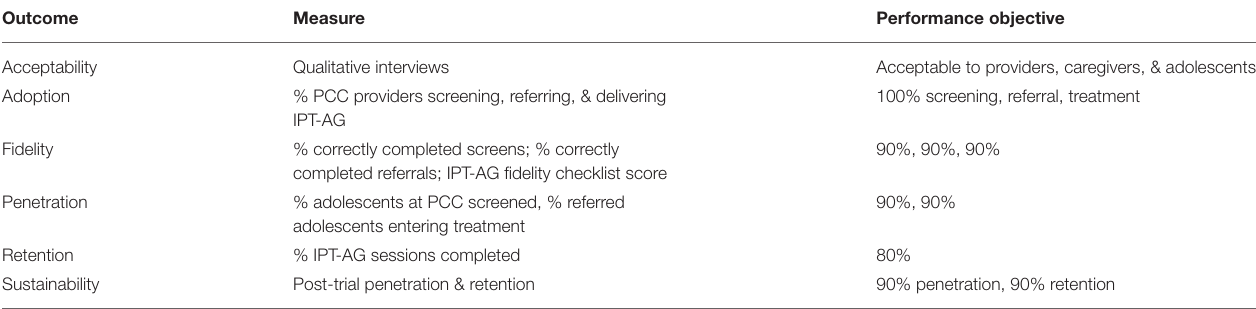
TABLE 1 | Implementation outcomes and performance objectives for integrated adolescent depression services in Mozambican primary care. Outcome